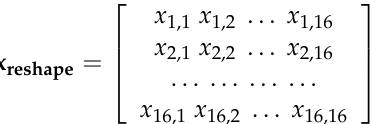
Table 2. The complex permittivity of the